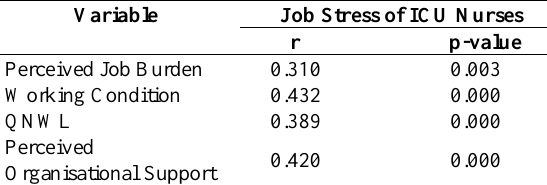
Table 3. Correlation of Job Stress Among ICU nurses (Pearson’s